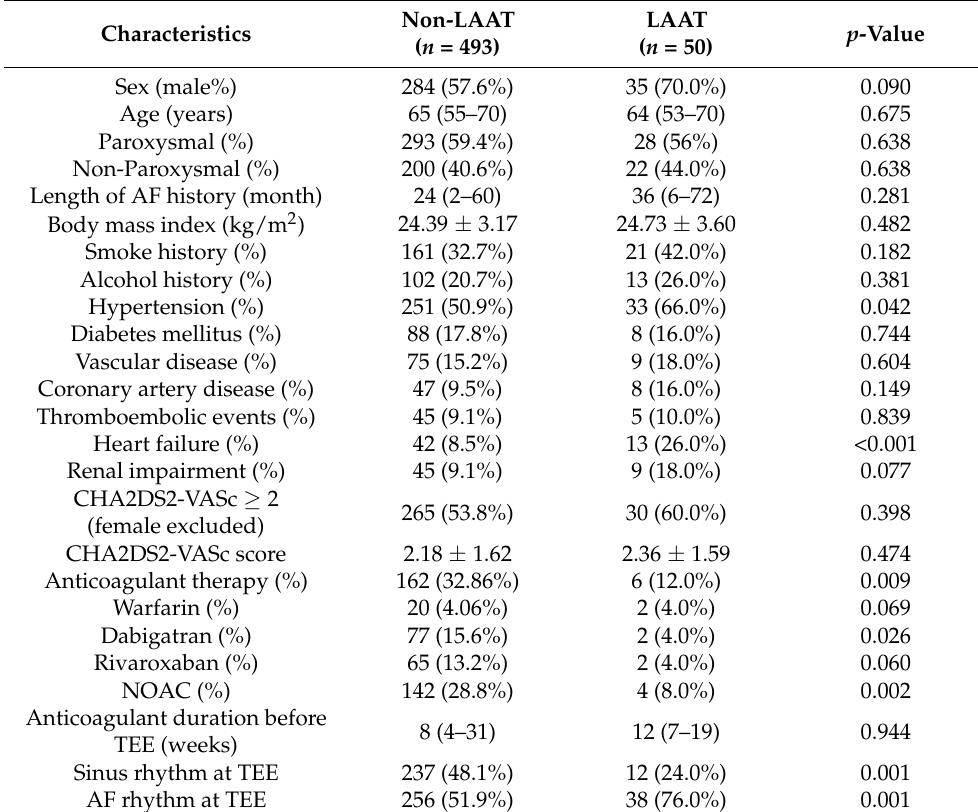
Table 1. Baseline characteristics of both groups for entire cohort.